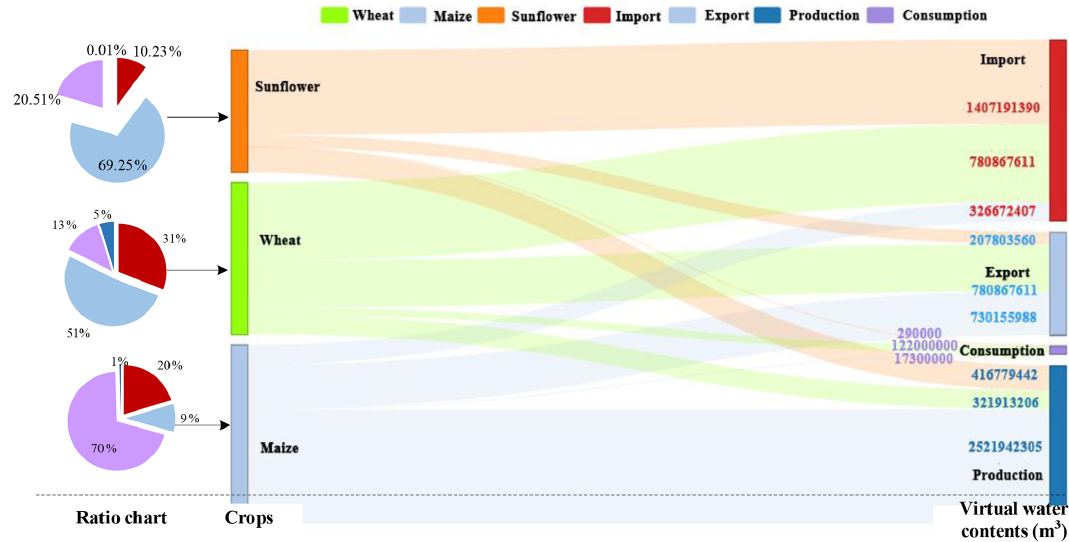
Figure 6. The amount of inter-regional export and international import trade (m 3